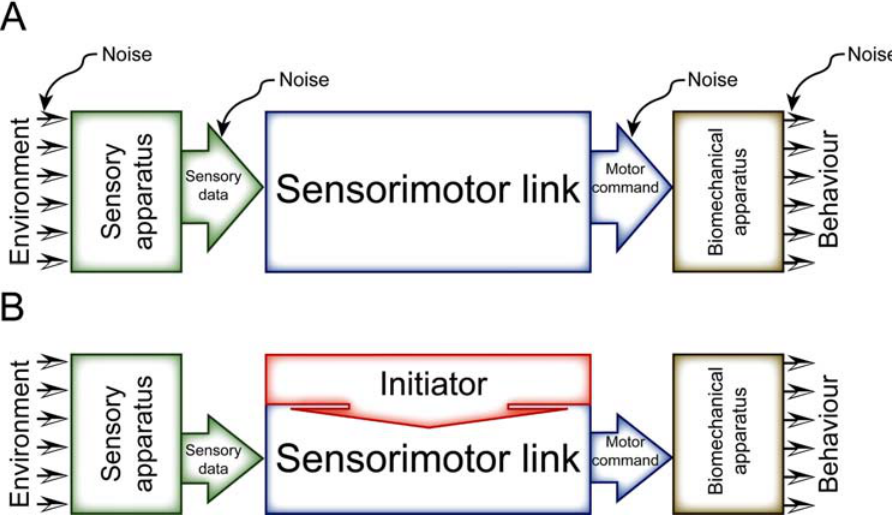
Figure 1. Alternative models conceptualizing the open-loop experiment. A–According to the robot-hypothesis, there is an unambiguous mapping of sensory input to behavioral output. If the behavioral output is not constant in a constant environment, there are a number of possible sources of noise, which would be responsible for the varying output. B–In a competing hypothesis, non-constant output is generated intrinsically by an initiator of behavioral activity. Note that the sources of noise have been omitted in B merely because their contribution may be small, compared to that of the initiator, not because they are thought to be non-existent.